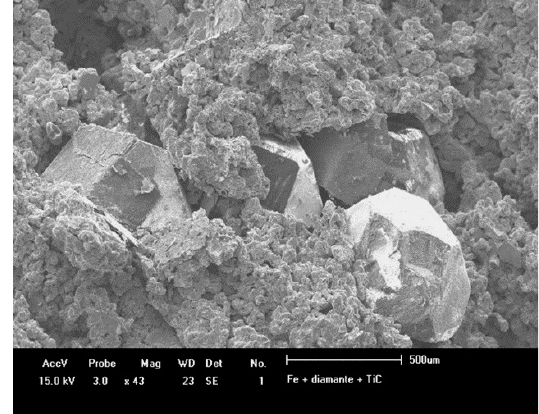
Figure 14. Micrograph of Fe-TiC coated diamond composite after compression tests.